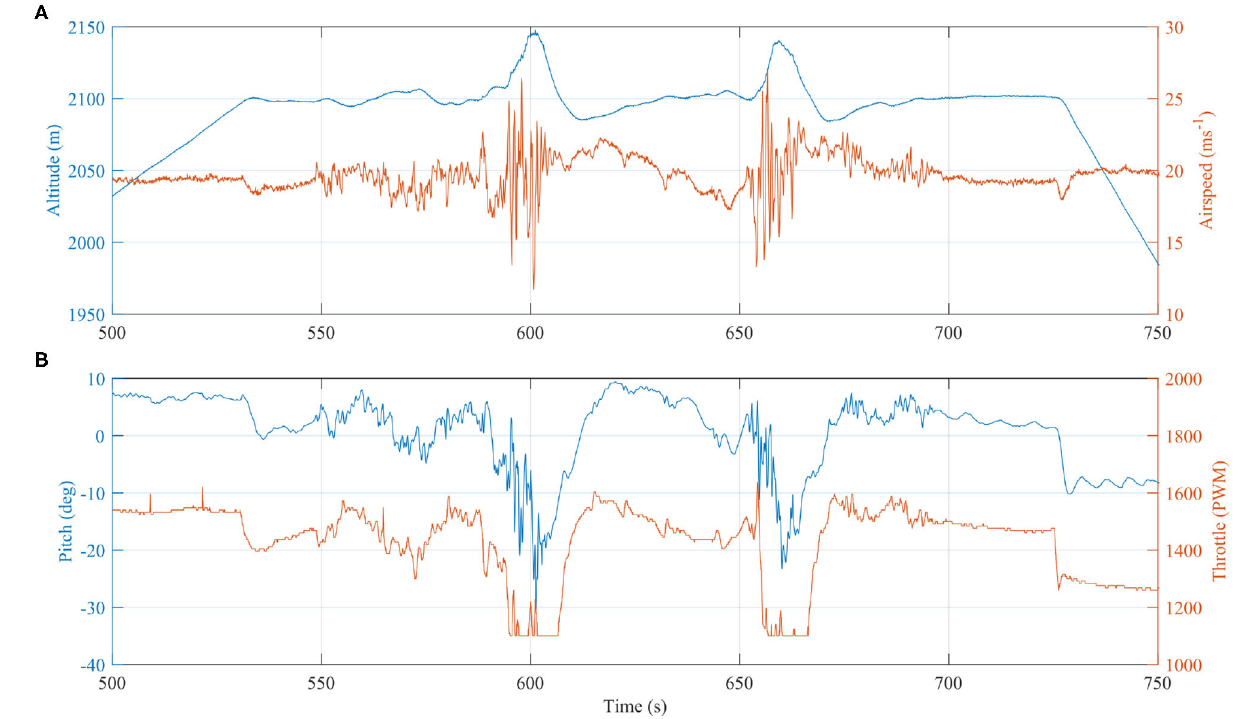
FIGURE 7 | Time series of (A) altitude and airspeed, and (B) throttle and pitch, with a common time axis as the vehicle encountered the rising plume. Due to the hot rising buoyant plume air mass, the vehicle gains altitude despite reducing throttle to zero and orientating nose down with a negative pitch